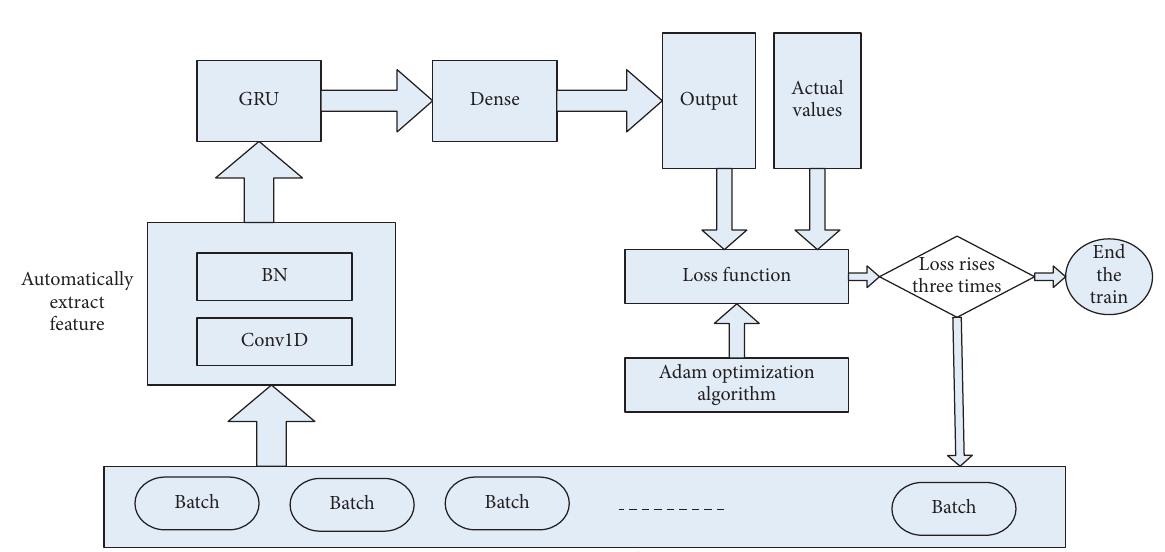
Figure 16: Conv1D_ GRU model training